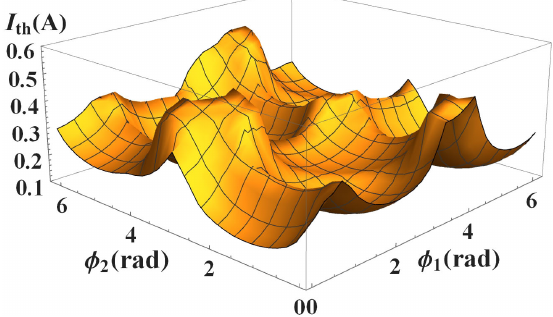
FIG. 12. A scan of BBU I over the two free phases for the th CBETA 1-pass lattice with x-y coupling. Each cavity is assigned with a random set of 3 dipole HOMs in both x and y polarization. ( ϵ ¼ 125 μ m). For this particular HOM assignment, I ranges th from 140 mA to 520 mA.